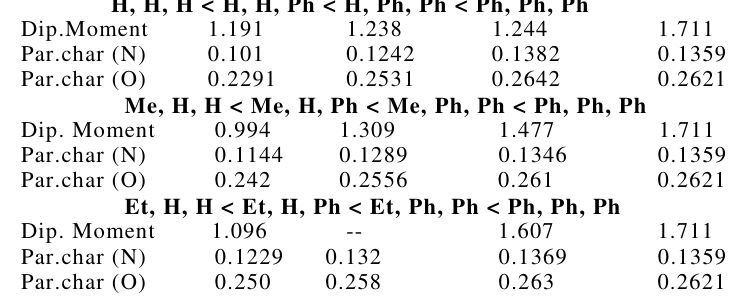
This dependence of the physico-chemical parameters with respect to dipole moment values